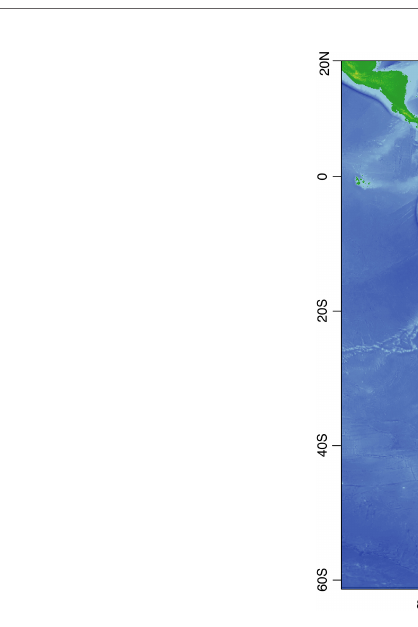
FIGURE 1 | Map of sampled stations. Larger circles indicate the three stations (7, 15 and 23) along the cruise track where taxonomic metagenomic and metatranscriptomic data were collected in tandem, with smaller dots representing stations where water column chemical data and microbial taxonomic data were obtained. Base maps with bathymetry were obtained from the General Bathymetric Chart of the Oceans (GEBCO), 2020